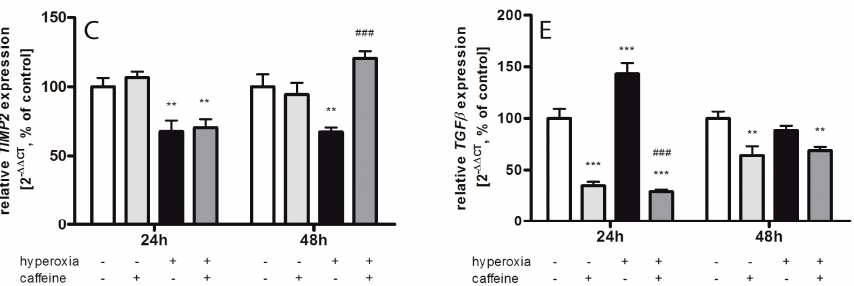
Figure 6. Hyperoxia-mediated imbalance in the MMP-TIMP system counteracted by caffeine. ( Box ) The matrix metalloproteinase (MMP) system can be activated via the plasminogen/plasmin system, and ROS. Active MMPs affect a variety of extracellular and immune regulatory proteins and are involved in modulating and degrading processes. Active MMPs can be inhibited by tissue inhibitors of metalloproteinases (TIMPs). TGF- β can enhance the expression of MMPs and TIMPs. MMP2 and MMP9 are able to cleave PARP-1. The MMP inhibitor TIMP2 is able to block PARP-1 degradation. The pro and active MMPs were analyzed with gelatin zymography and relative mRNA expression were measured in brain homogenates of normoxia ( white bars ), caffeine with normoxia (light grey bars), hyperoxia ( black bars ), and hyperoxia with caffeine ( dark grey bars ) by quantitative real-time PCR of: ( A ) pro/active MMP2; ( B , C ) TIMP1/2 mRNA; ( D ) tissue plasminogen activator ( tPa ) mRNA; and ( E ) TGF- β mRNA. Data are shown as mean ± SEM, n = 4 (for gelatin zymography)-5 per group per time point. The 100% value is ( A ) (pro) 7.849 × 10 6 and 0.949 × 10 6 intensity/mm 2 and (active) 11.18 × 10 6 and 0.731 × 10 6 intensity/mm 2 ; ( B ) 1.043 and 1.004 C T ; ( C ) 1.008 and 1.017 C T ; ( D ) 1.013 and 1.026 C T ; and ( E ) 1.018 and 1.010 C T for 24 and 48 h groups, respectively. Data were analyzed by two-way ANOVA with Bonferroni post hoc test, with * p < 0.05, ** p < 0.01, and *** p < 0.001 versus control (atmospheric air), and ## p < 0.01 and ### p < 0.001 versus hyperoxia (80% oxygen without caffeine).